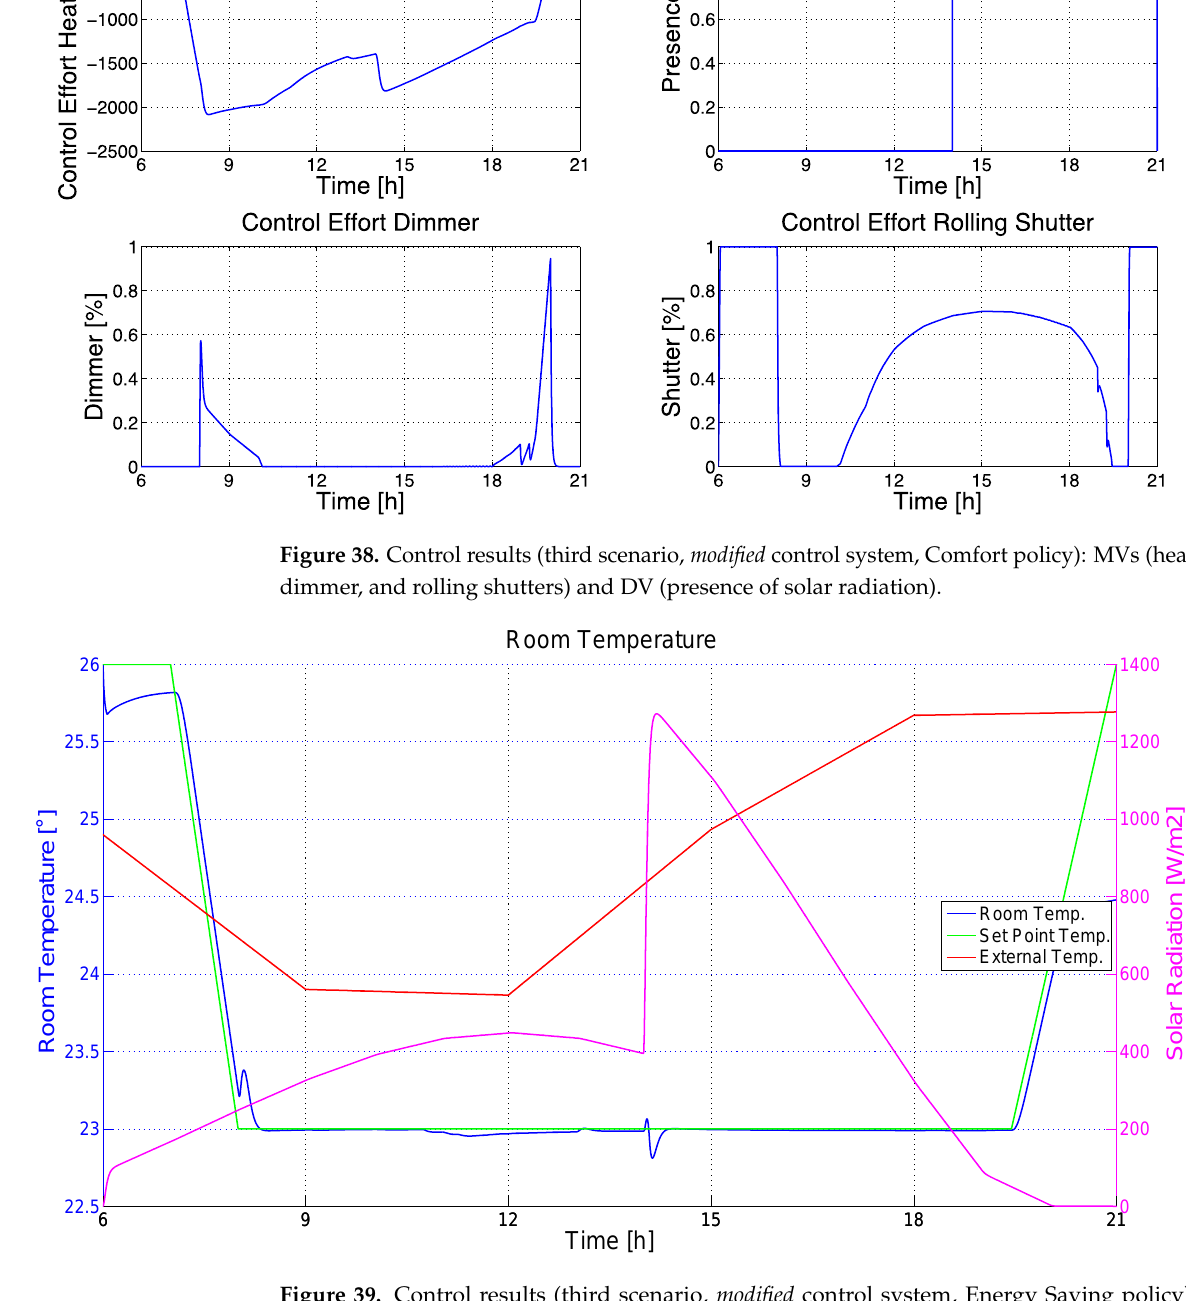
Figure 40. Control results (third scenario, modified control system, Energy Saving policy): room illu- minance (CV). Figure 41. Control results (third scenario, modified control system, Energy Saving policy): MVs (heat pump, dimmer, and rolling shutters) and DV (presence of solar radiation).